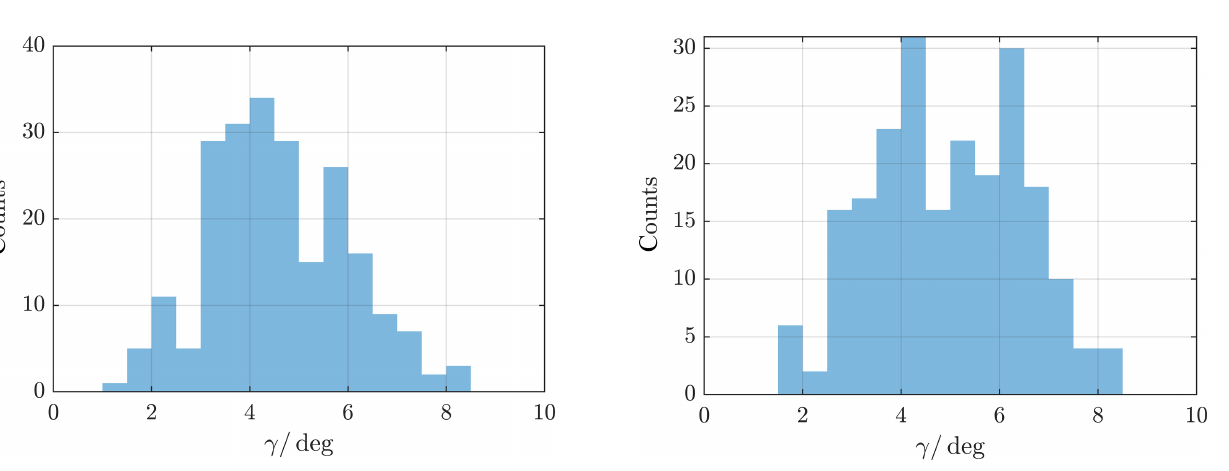
Figure 9. Angle between model MP normal direction of every crossing event and the yz GSM plane; see angle γ in Fig. 8. Angles with a mean of 4 . 6 ◦ are expected.